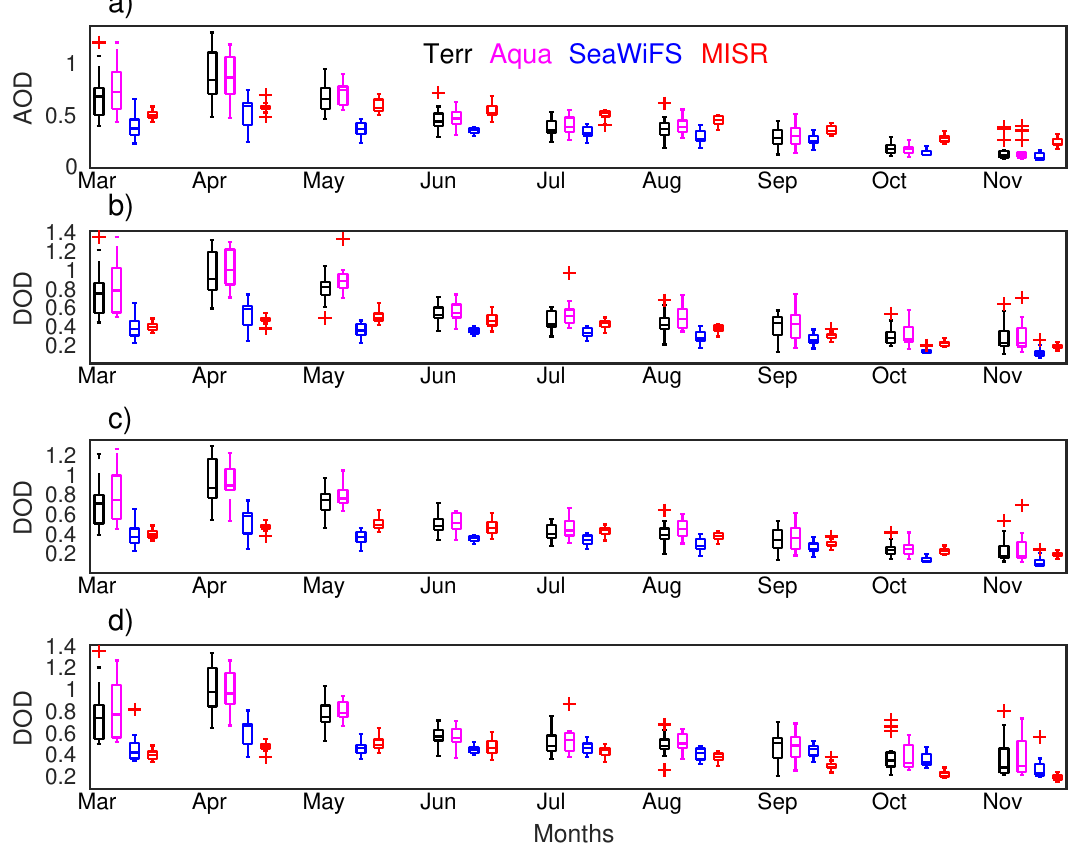
Figure 8. The statistic metrics of the annual distribution of monthly mean AOD ( a ); and derived DOD (0.55 µ m) with the three criteria ( b – d ) (corresponding to Criteria 1, 2, and 3, respectively) during the examined period from MODIS, SeaWiFS, and MISR. The red “+” indicates AOD/DOD of extreme